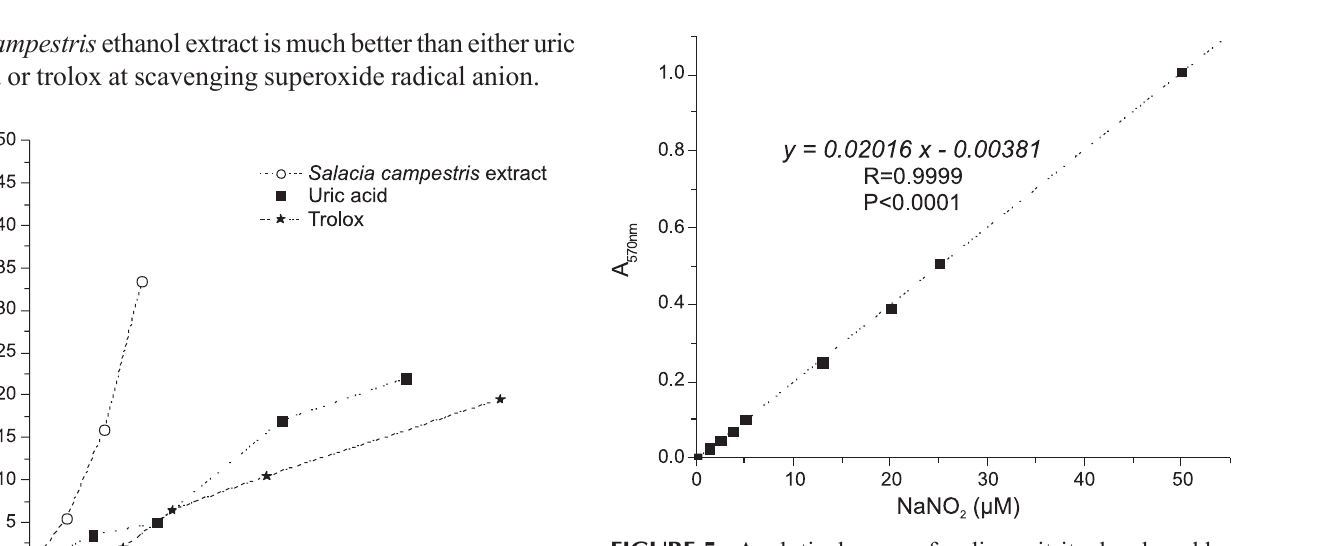
FIGURE 5 - Analytical curve of sodium nitrite developed by Griess Reagent. The reactions were made in 50 mM sodium phosphate buffer, pH 7.0, 25 0 C, and incubated by 15 min.